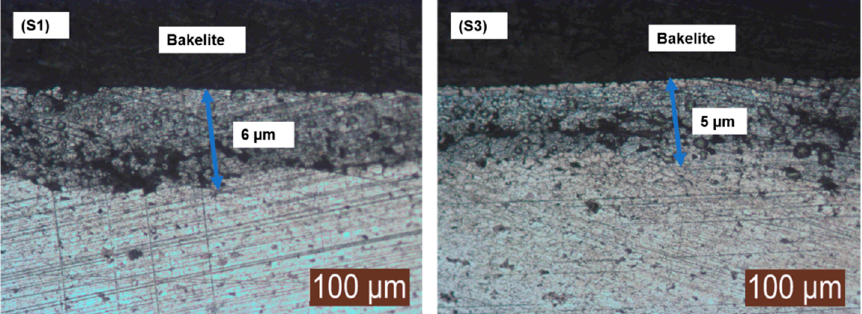
Figure 7. Surface nitride layer formation.